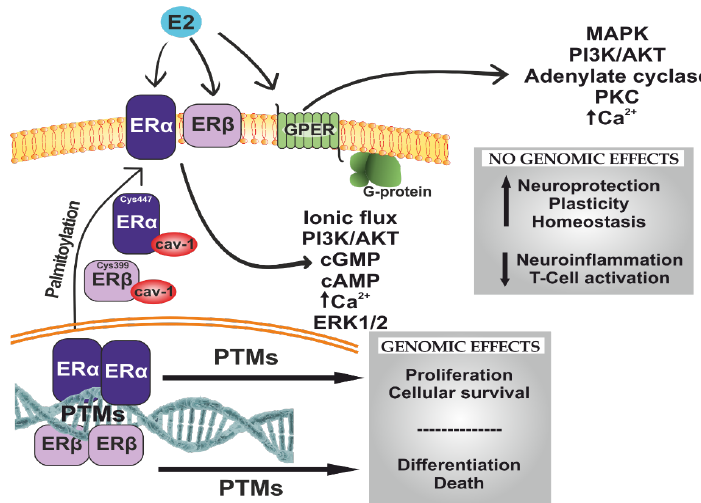
Figure 2. Schematic representation of the effects of estrogen receptors (ERs) after estradiol binding. ERα and ERβ need to dimerize to bind to DNA estrogen response elements after activation with estradiol. These dimers could be homodimers or heterodimers, but the proportion of homodimers is higher. The effects of ERs depend on the tissue they are in, the proportion of each type of receptor, and the crosstalk between them. In general, ERβ antagonize ERα, with different effects on tissue. Furthermore, there are some post-translational modifications (PTMs), both before receptors attach to DNA and after that. Palmitoylation in Cys447 in ERα and Cys399 in ERβ allows them to interact with caveolin-1 (cav-1) and be translocated to the membrane as monomers. G protein-coupled estrogen receptor (GPER) is a receptor associated to Gαq proteins, triggering numerous nongenomic effects. Based on [191,192].